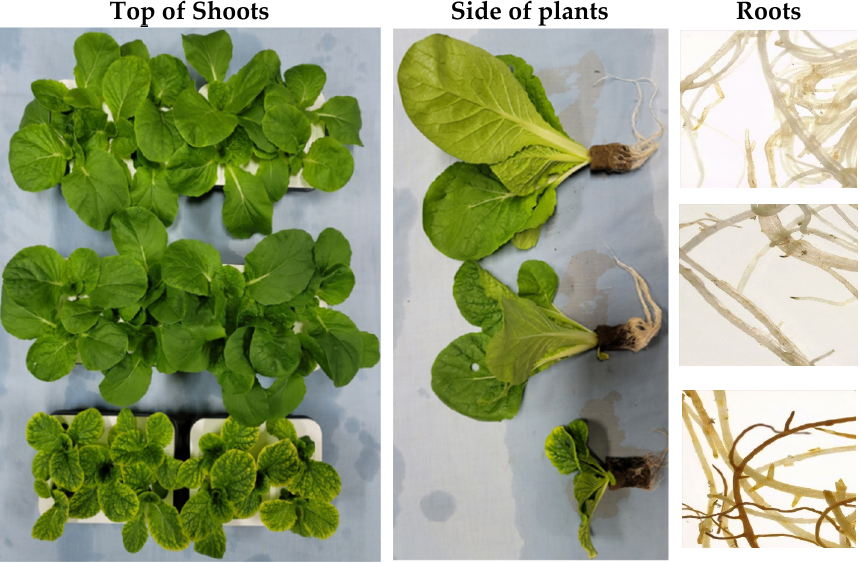
Figure 2. Growth of Ssamchoo as affected by nutrients 28 days after sowing in Experiment 1. Peters Professional, GNU1, and GNU2 were the nutrient solutions used in the experiment. Peters Professional is a commercial nutrient